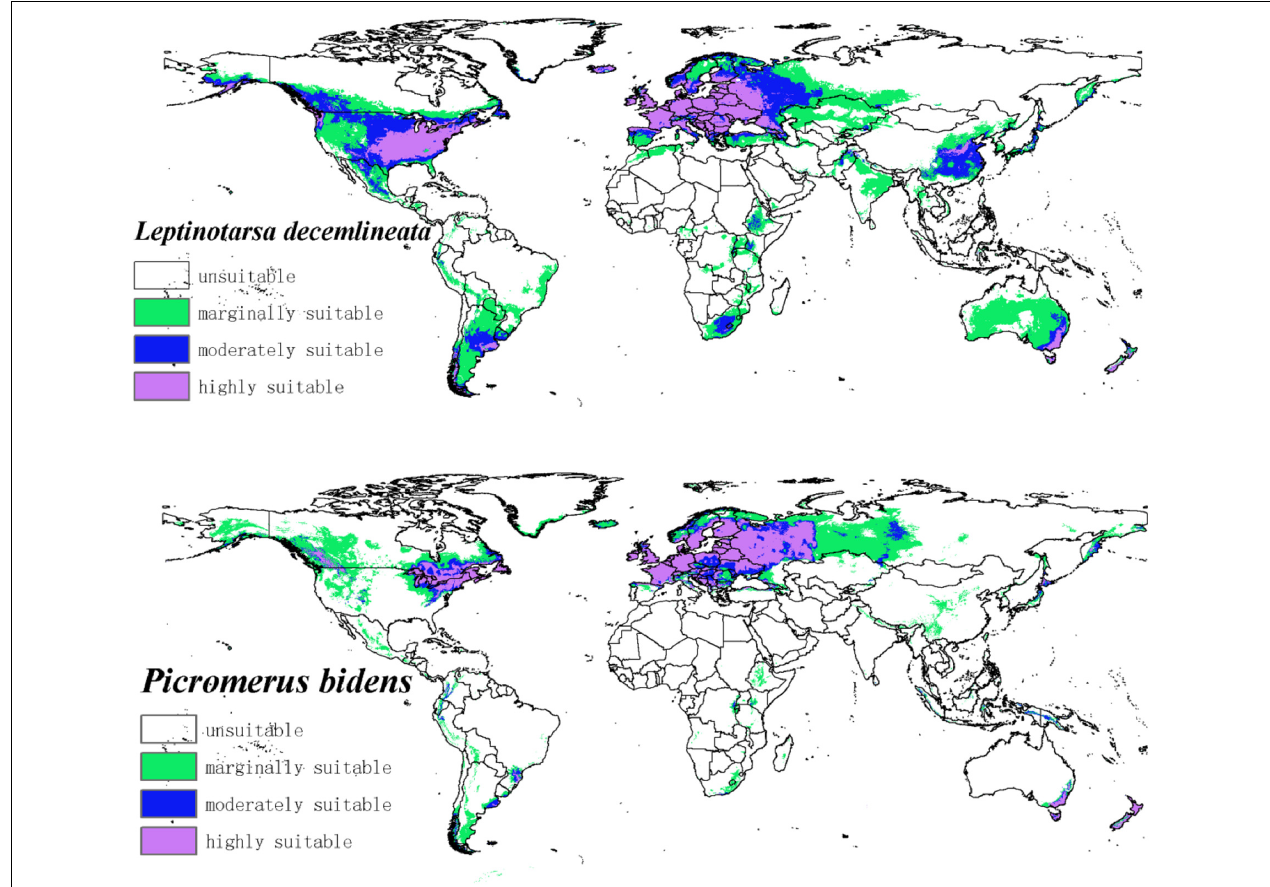
FIGURE 4 | The potential distribution of CPB and P. bidens under current climate. The shade of color represents the level of suitability.